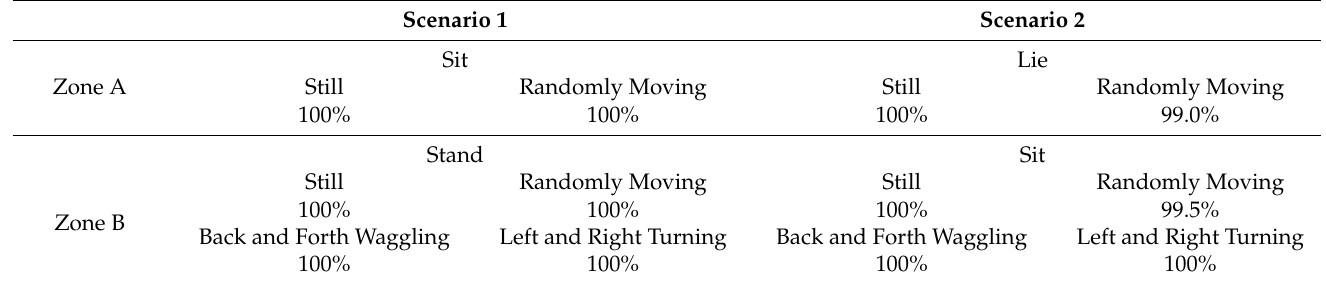
Table 6. Activity monitoring accuracies in 12